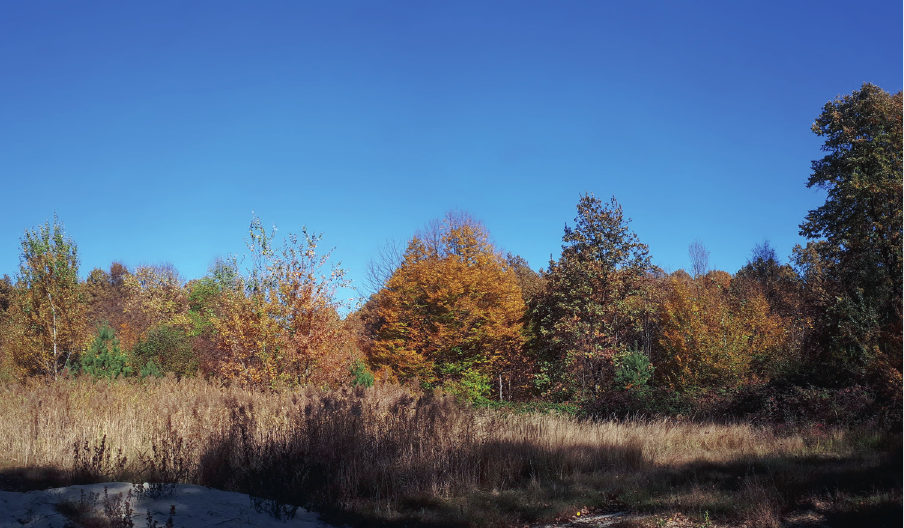
Figure 1. Natural habitat of Eriogaster catax in the Oltenilor Forest, Olteni, Dâmbovița